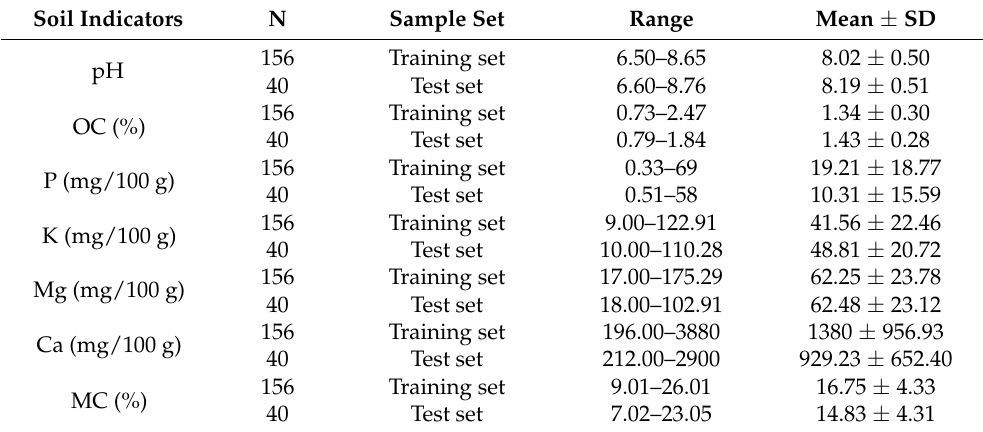
Table 2. Descriptive statistics of laboratory measured soil attributes for selected sample sets used for building training and test